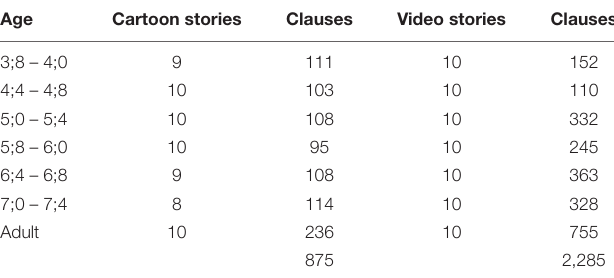
TABLE 1 | Cartoon and video